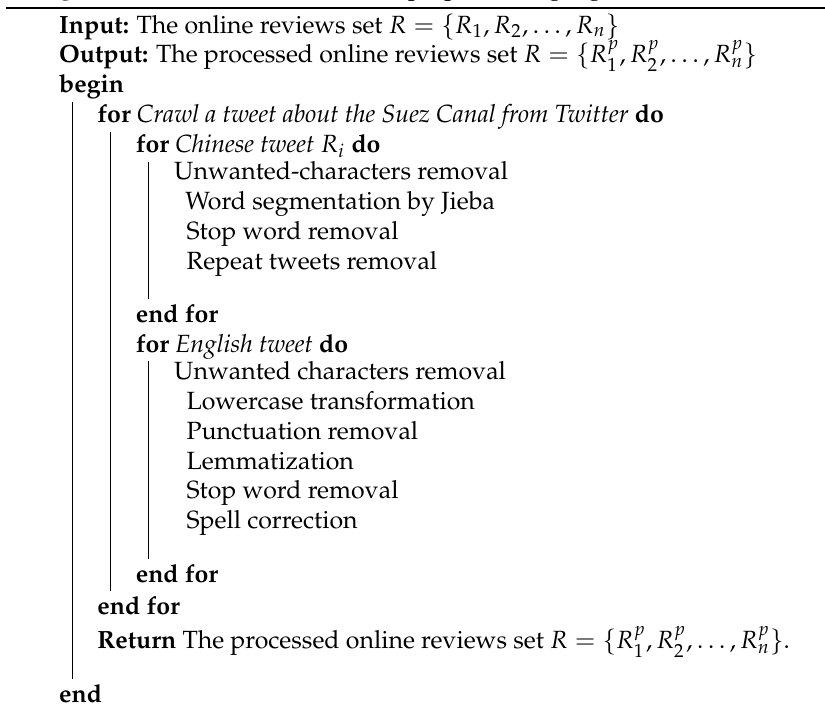
Algorithm 1: Data collection and preprocessing algorithm.